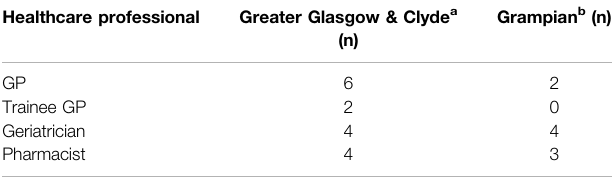
TABLE 1 | Breakdown of HCP roles of